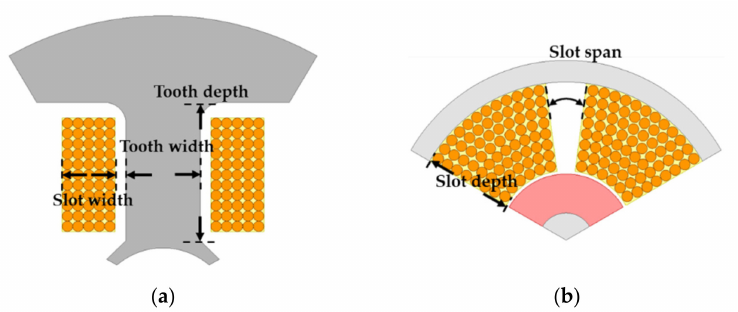
Figure 7. Illustration of key stator geometric parameters for the ( a ) slotted stator and ( b ) slotless stator PM